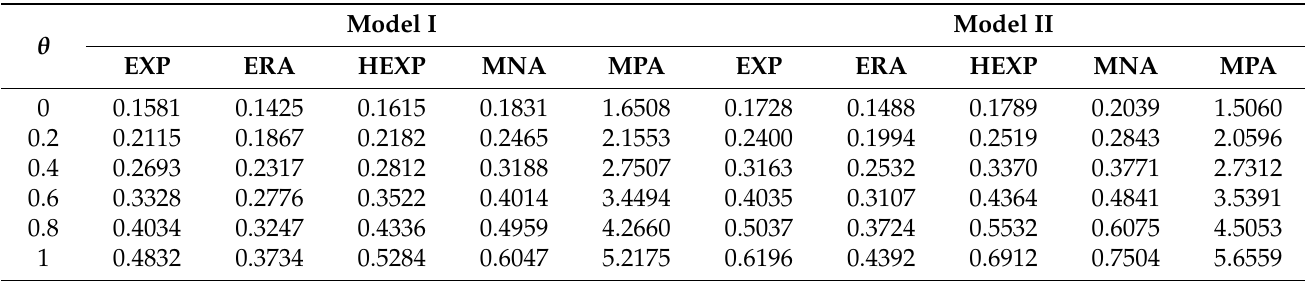
Table 4. Effect of θ on expected number of P 2 customers in the system (when L =